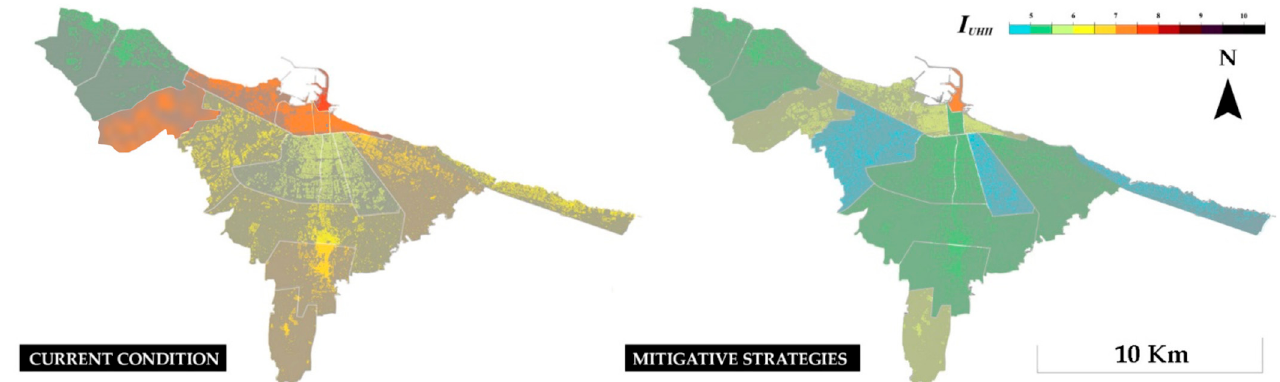
Figure 8. Current UHI intensity map of Bari ( left ) compared with the most effective mitigation scenario involving the highest possible increase in greenery ( right ).